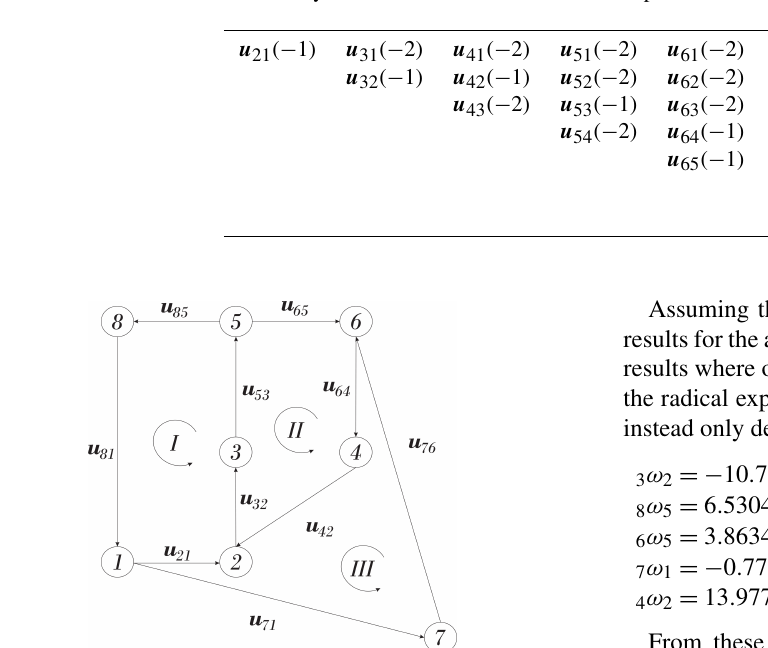
Table 2. Instantaneous axes of velocity associated with the indeterminate spherical mechanism.